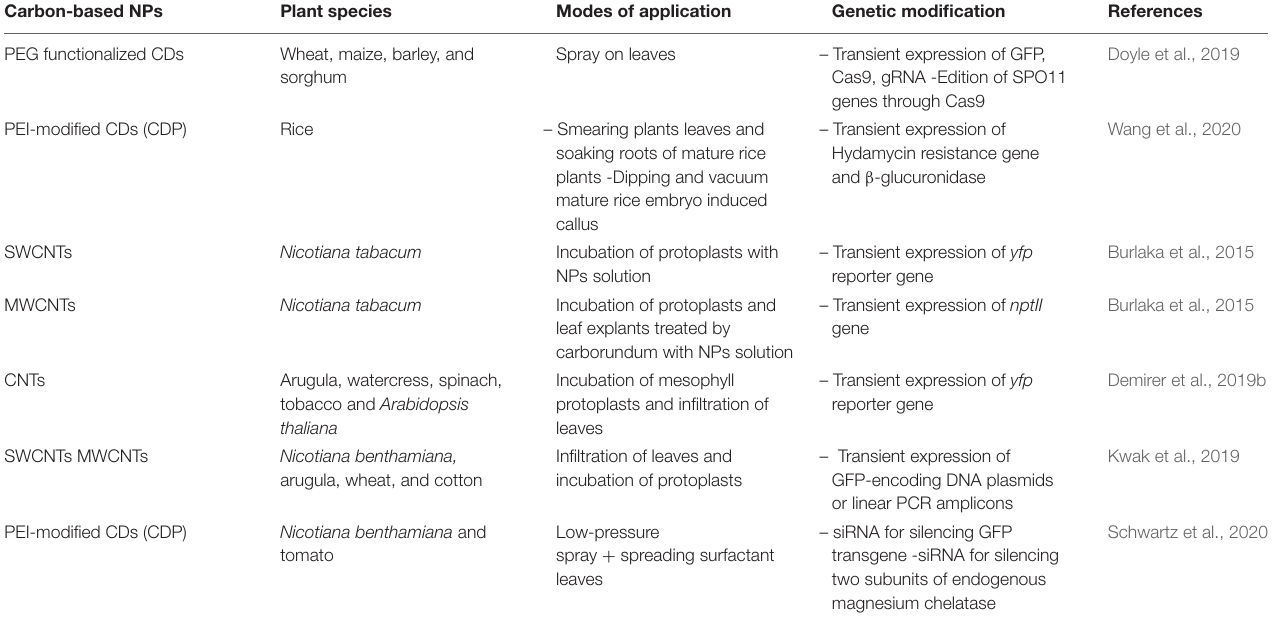
TABLE 3 | Carbon-based nanoparticles NPs as biomolecule carriers for transient